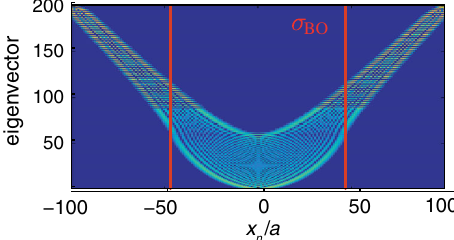
FIG. 8. Bloch oscillations: eigenfunctions of Hamiltonian Eq. (1) illustrating Wannier-Stark localized eigenfunctions at the edge of the lens (see